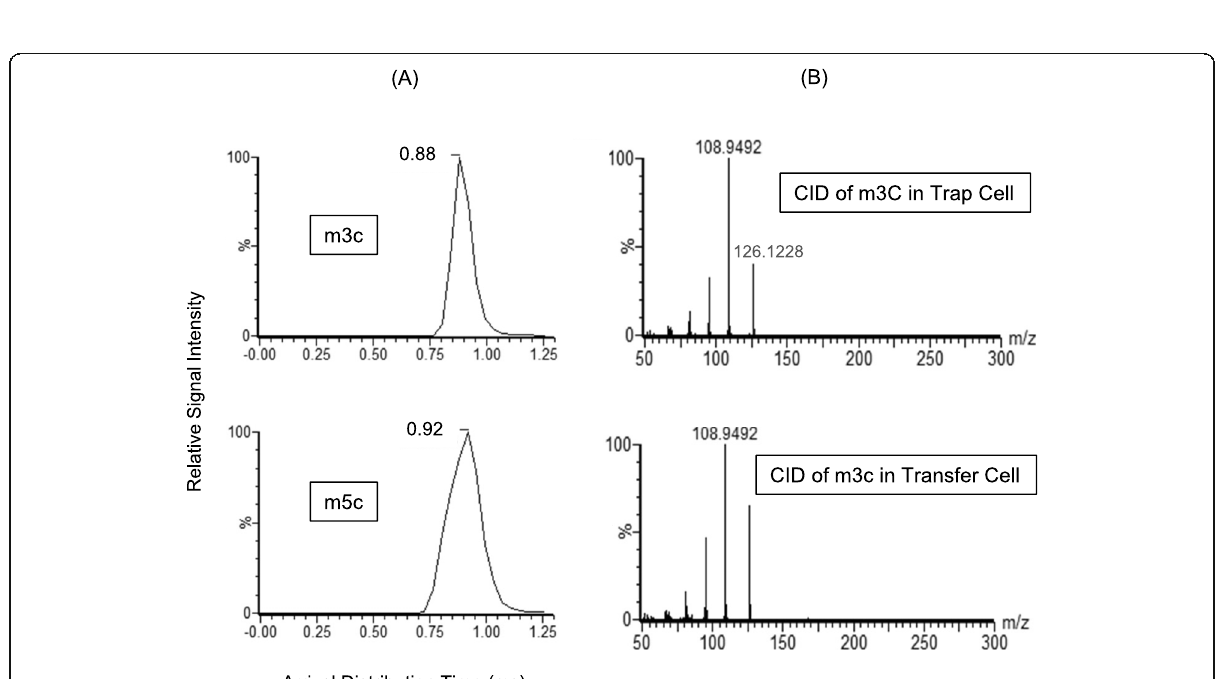
Fig. 5. a Extracted ion mobility spectra of nucleobases that resulted from using the SRI method. b MS/MS spectrum of m3C in the trap cell under the standard MS/MS method or m3c in the transfer cell under the SRI method. The CID energy used in the trap and transfer cell was 80 V and 140 V, respectively. The ion counts for 108.9492m/z ion in both cases reached 5e+4 and 4e+4, respectively. m3c, 3-methylcytosine; m5c, 5- methylcytosine; m3C,